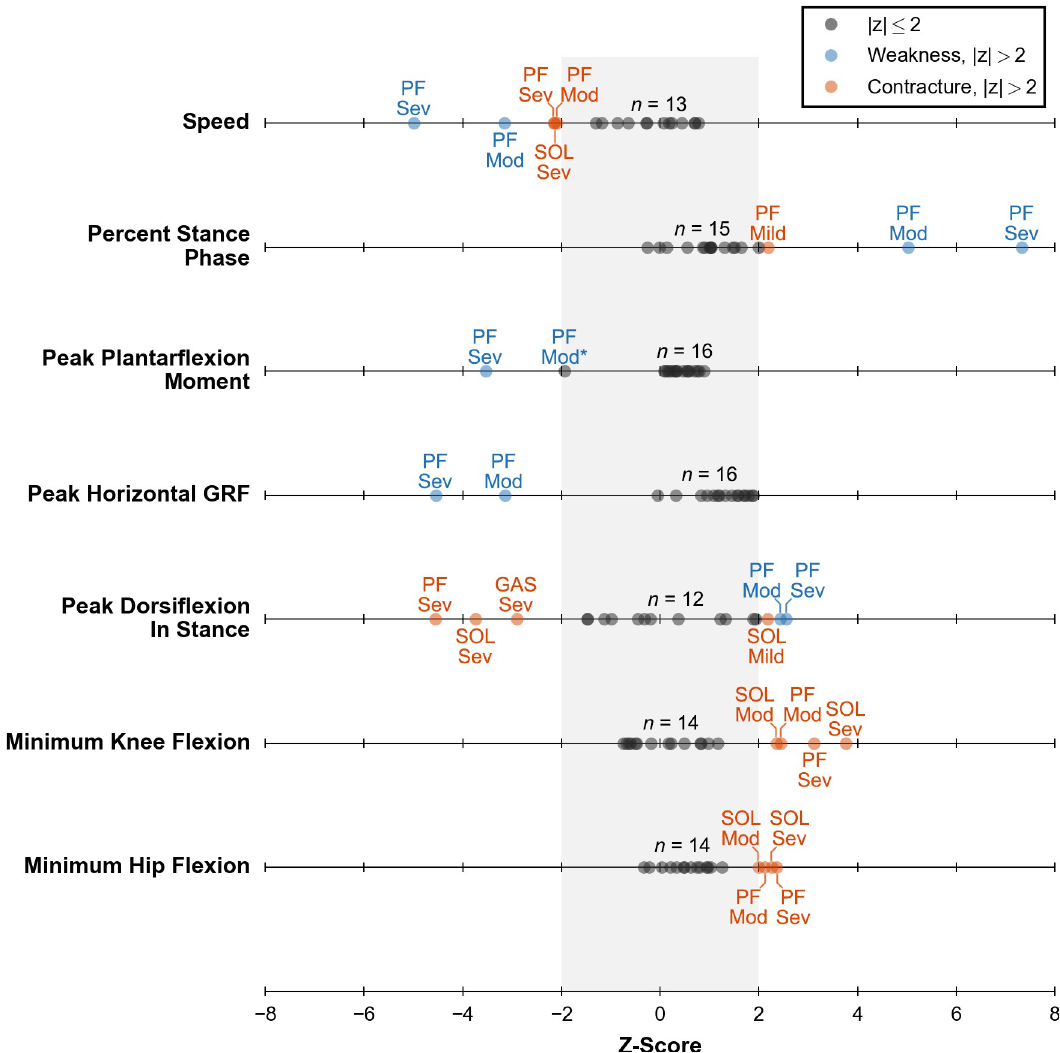
Fig 8. Z-scores of key kinematic and kinetic measures of gait for all deficit cases. Z-scores were computed using previous experimental data of individuals walking at a self-selected speed from Schwartz et al. [58]. All 18 cases (dots) are plotted for each measure. A black dot indicates any case within 2 SDs of normal (gray band). A blue or orange dot indicates either a weakness or contracture case, respectively, which is outside of 2 SDs. All of these cases are labeled with the affected muscle or muscles: soleus (SOL), gastrocnemius (GAS), or both (PF); and severity level: mild (Mild), moderate (Mod), or severe (Sev). One other case is labeled (see Peak Plantarflexion Moment, PF Mod � ) as it was a clear outlier compared to other deficit cases. The count above each line (e.g., n = 13 ) indicates the number of unlabeled